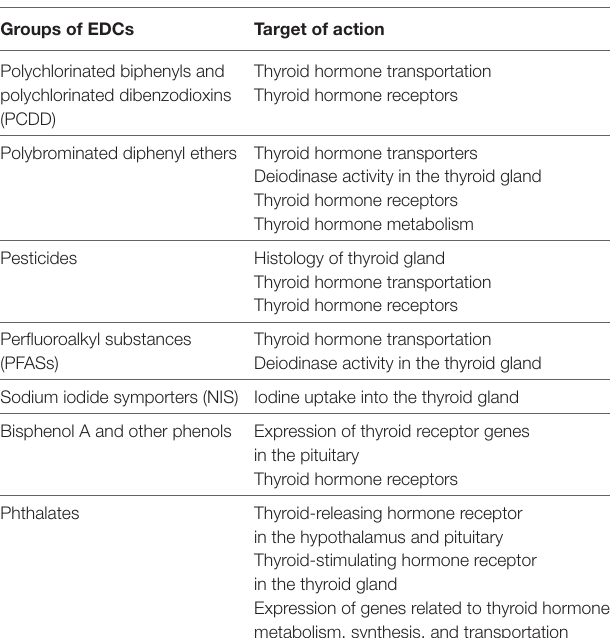
FiguRe 1 | Thyroid signaling pathway and endocrine-disrupting chemicals. Groups of chemicals act at: PCB and PCDD: 5, 7; PBDEs: 5, 6, 7, 8; pesticides: 4, 5, 7; PFASs: 5, 6; NIS: 3; BPA: 2, 7; phthalates: 1, 2, 5, 8. Abbreviations: BPA, bisphenol A; NIS, sodium iodide symporters; PBDE, polybrominated diphenyl ethers; PCB, polychlorinated biphenyl; PCDD, polychlorinated dibenzodioxins; PFAS, perfluoroalkyl substances; TRH, thyroid-releasing hormone; TSH, thyroid-stimulating hormone; T4, thyroxine; T3, triiodothyronine. Image of thyroid: by P. J. Witt, AU from the Noun Project, Creative Commons.